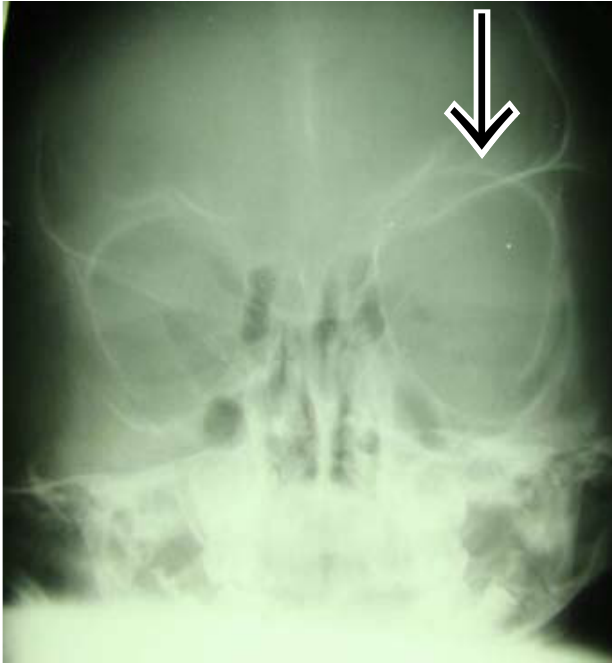
Fig. 1. Frontal X-ray of the skull showing harlequin appearance of the left orbit owing to hypoplasia of the greater wing of the sphenoid bone.